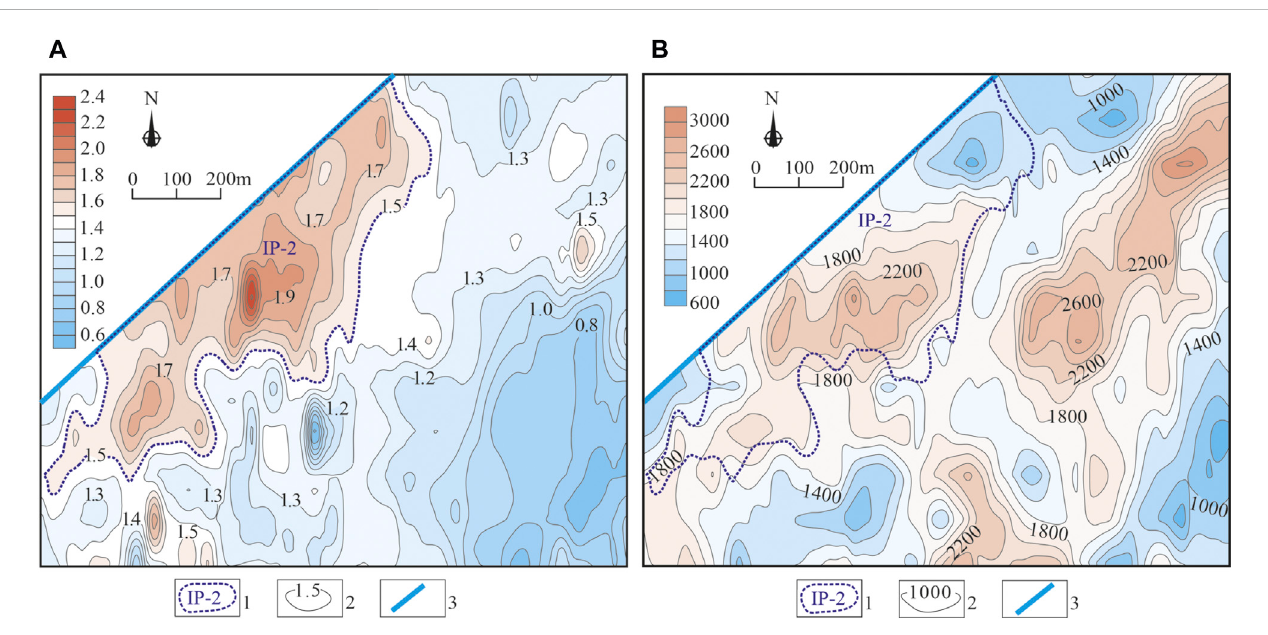
FIGURE 6 Plan-view contour of IP Mid gradient polarizability( η s ) (A) and IP Mid gradient apparent resistivity( ρ s ) (B) of Xinchenggou area, Dongning County. 1- Anomaly of IP Mid gradient and its number; 2-Anomaly contour and value; 3-Mine fi eld border.